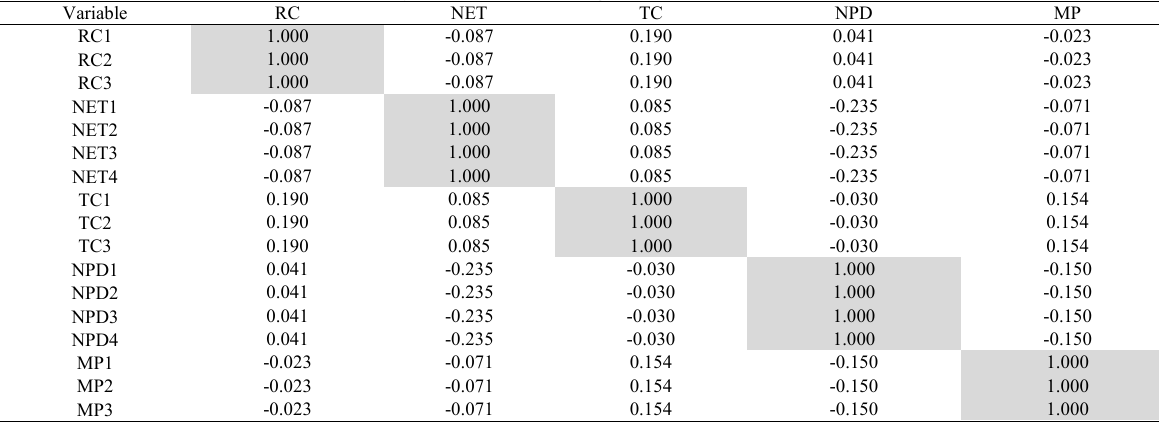
Evaluation of measurement models (validity test) Outer Loading Variable RC NET TC